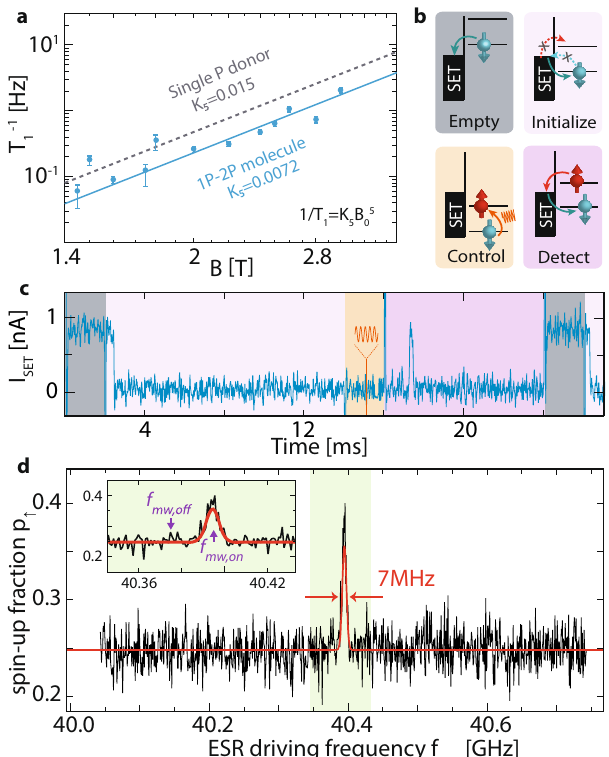
Fig. 2 Spin relaxation and resonance spectrum of the 1P – 2P molecule ’ s fi ve-electron state. a Spin relaxation rate measurement of the fi ve-electron state, as a function of magnetic fi eld. Error bars indicate 95% con fi dence intervals. The known T 1 time of a single electron bound to a single P donor is shown in grey. b Energy level diagrams for each stage of the pulse sequence used in the spin control experiments, showing the potentials of the Zeeman states relative to the SET Fermi energy. c Example readout trace of the SET current as a function of time, for a representative four stage pulse sequence incorporating an ESR control pulse. d Electron spin resonance spectrum of the fi ve-electron state of the 1P – 2P molecule at B = 1.45 T. The fi tted peak width is 7 MHz. The inset displays a narrower 0 range of frequency settings and marks the two frequencies f mw,off , f mw,on used in the coherent driving